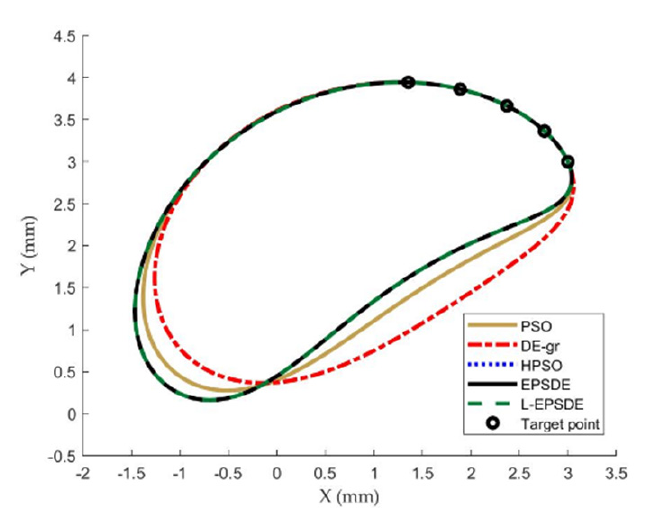
Figure 8. Trajectories of the coupler point of Case 1.